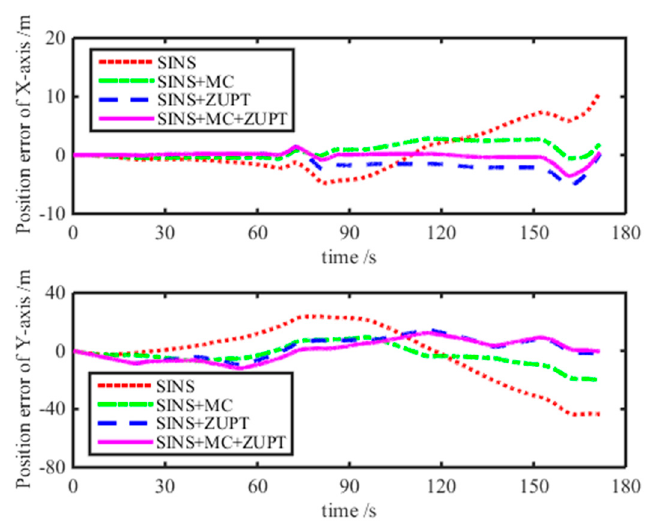
Figure 10. Position error of the SINS with different correction methods.